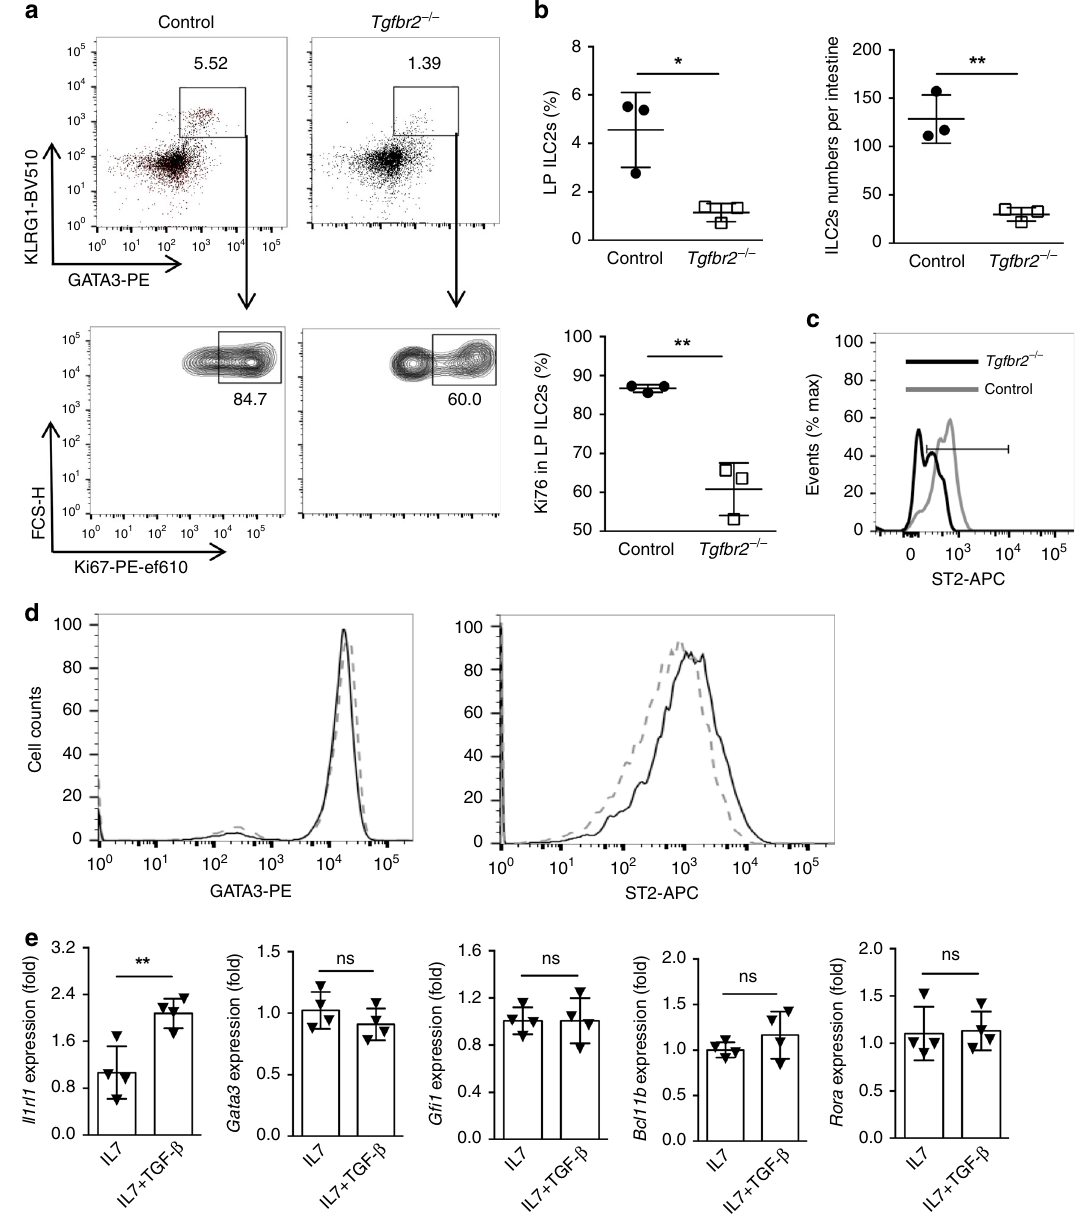
Fig. 6 TGF- β signaling maintains mature ILC2s in the periphery. a Sorted mature ILC2s (CD45.2 + Lin − CD127 + Sca1 + CD25 + KlRG1 + ) in the LP of tamoxifen- ( Tgfbr2 − / − ) or oil-treated (Control) Tgfbr2 f/f ER-Cre + mice were adoptively transferred into Rag2 − / − Il2rg − / − mice. Frequencies and Ki67 expression of GATA3 + KLRG1 + ILC2s among CD45.2 + Lin − CD127 + cells in the LP of these recipients were assessed by fl ow cytometry after 12 days. b The frequency, total number, and Ki67-positive percentage in LP ILC2s gated in a ; n = 3 mice per group. c Representative FACS histograms of ST2 expression by ILC2s in the lung of Control/CD45.1 and Tgfbr2 − / − /CD45.1 BM chimeras. d Representative FACS histograms of sorted WT CD45.2 + Lin − CD127 + Sca1 + CD25 + KlRG1 + ILC2s cultured with IL-7, in the presence (black solid line) or absence (gray dashed line) of TGF- β 1 and analyzed for the expression of GATA3 and ST2 among live CD45 + Lin − CD127 + cells after 3 days. e Quantitative RT-PCR analysis of the relative mRNA expression of selected genes in puri fi ed WT ILC2s cultured for 24 h in IL-7 alone or IL-7 plus TGF- β 1. In each experiment, sorted LP ILC2 cells were pooled from six mice in each group before cultures. Data are combined of two independent experiments and are presented as mean ± SD. * p < 0.05, ns, no signi fi cance (Student ’ s t